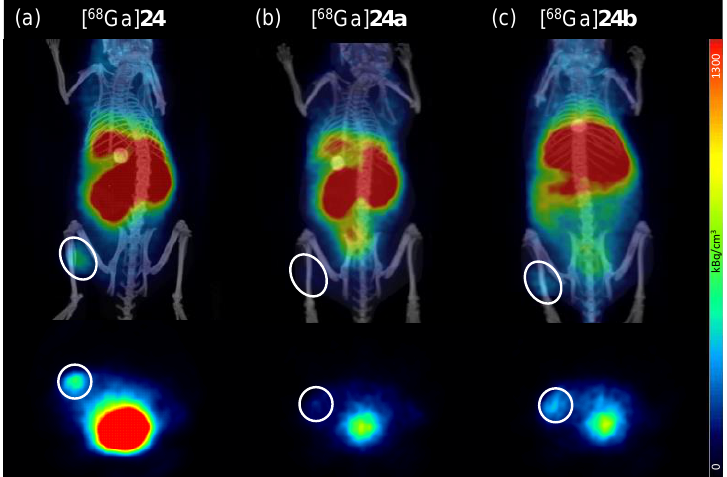
Figure 8. Representative small animal positron emission tomography/computed tomography (PET/CT) imaging results for [ 68 Ga] 24 ( a ); [ 68 Ga] 24a ( b ) and [ 68 Ga] 24b ( c ). The images show coronal ( upper row ) and transaxial ( lower row ) slices for all tracers at 37.5 min p.i. The same scaling was used for all images and 4 animals were examined per radioligand. The tumor is encircled in each image. Compared to the bispecific ligand [ 68 Ga] 24 with which the tumor can easily be delineated via PET/CT, the scrambled analogs [ 68 Ga] 24a and [ 68 Ga] 24b showed a considerably less efficient tumor visualization ability (Figure 8).